Question: Write a descriptive caption for this figure.
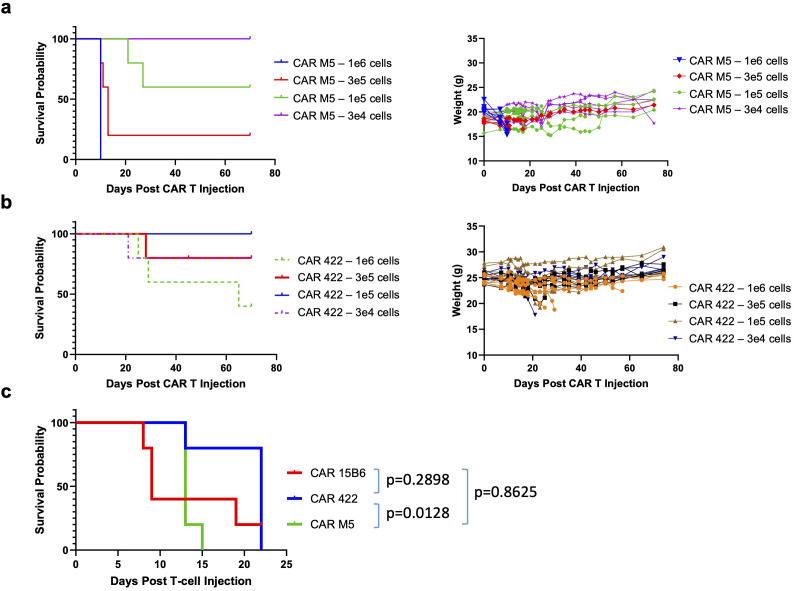
Answer: Evaluation of CAR T cell toxicity in huMSLN NSG mouse model. Non-tumor bearing huMSLN knock-in (KI) mice (n = 5 mice per group) were administered the indicated number of (a) CAR M5 or (b) CAR 422 T cells IV to assess off-tumor/on-target toxicity. Left-hand panels of (a) and (b) show probability of survival based on weight and health and right-hand panels of (a) and (b) show percent body weight change following T-cell injection as an indicator of toxicity and tolerability. (c) Non-tumor bearing huMSLN-KI mice (n=5 mice per group) were treated by injection of 1e6 CAR 422, 15B6, or M5 CAR T cells to evaluate relative toxicity. Statistical analysis used the Mantel-Cox log-rank test.